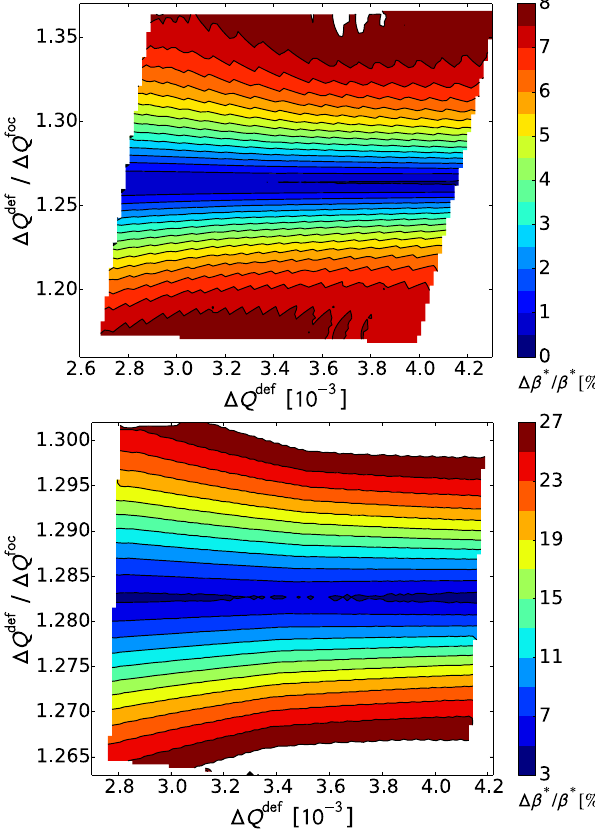
FIG. 4. Uncertainty on β (cid:1) measurements for δ Q (cid:3) 10 − 5 using k modulation for the LHC (top figure) and HL-LHC (bottom figure). The vertical axis shows the waist relative to the design β (cid:1) (LHC: β (cid:1)